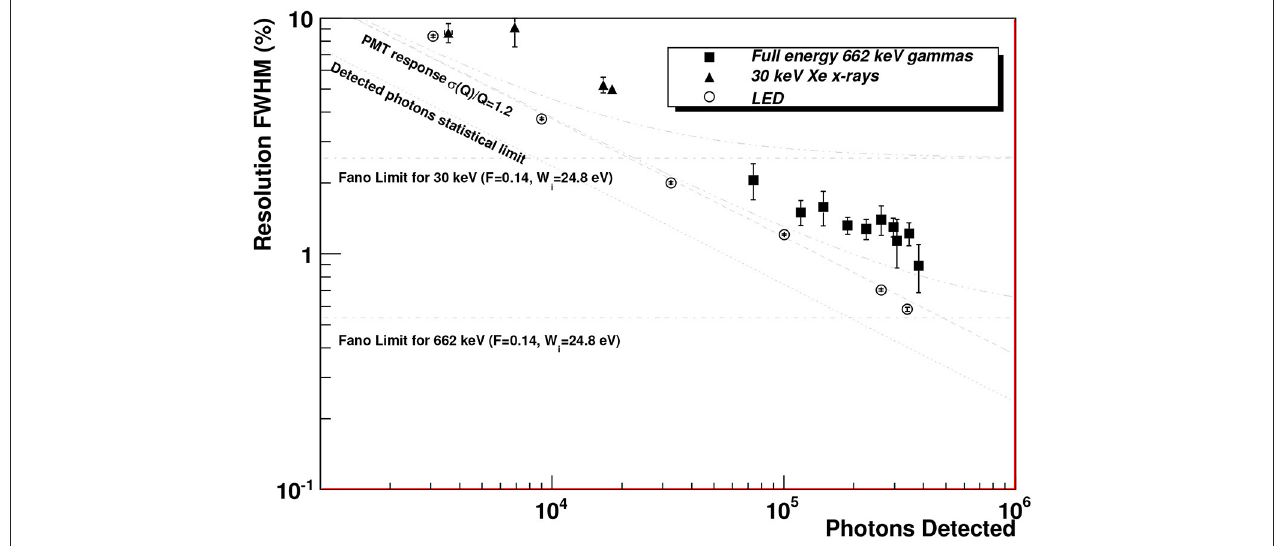
FIGURE 6 | Energy resolution measured by NEXT-DBDM: Data points show the measured energy resolution for 662keV gammas (squares), (triangles) and LED light pulses (circles) as a function of the number of detected photons. The expected resolution including the intrinsic Fano factor, the statistical fluctuations on the number of detected photons and the PMT charge measurement variance are shown for X-rays (dot dot dashed) and for 662keV gammas (dot dot dot dashed). Resolutions for the 662keV peak were obtained from 15bar data runs while X-ray resolutions were obtained from 10bar runs. Figure from Álvarez et al. [